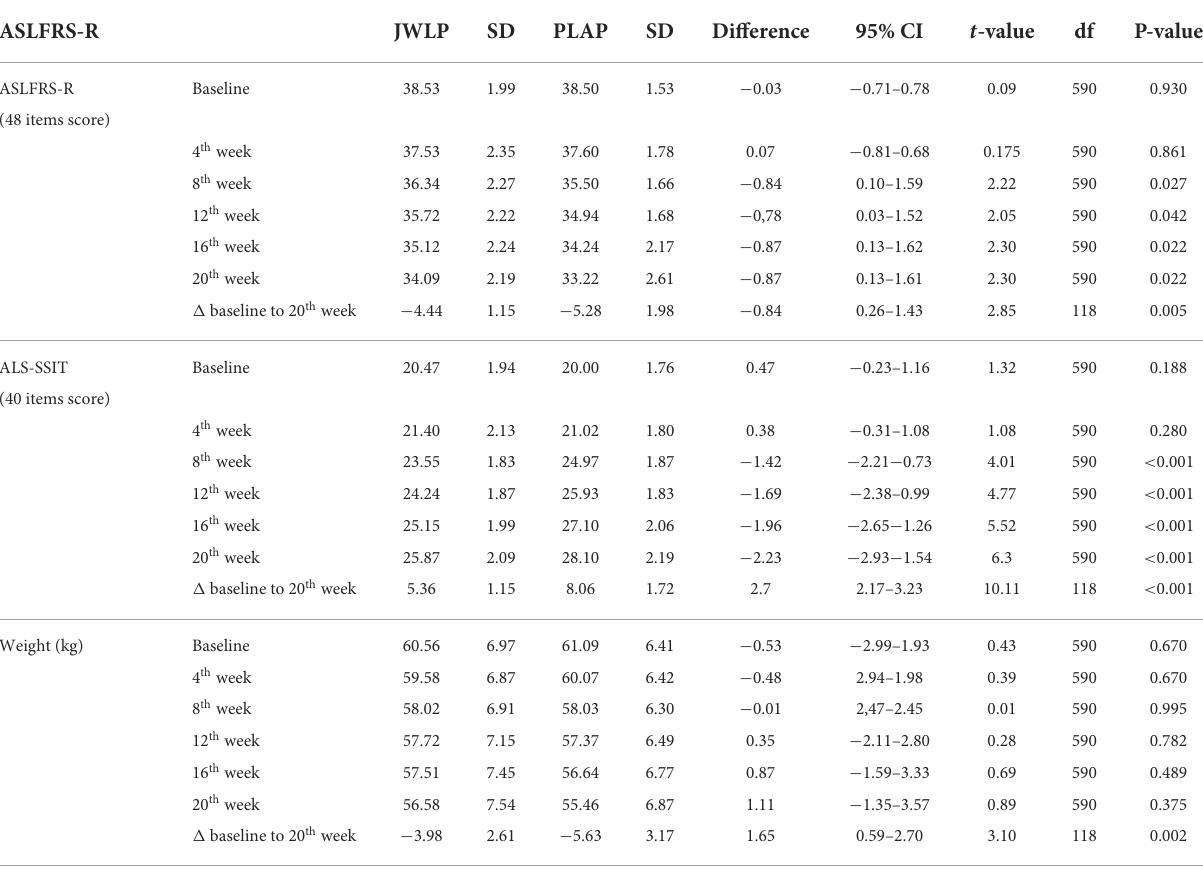
TABLE 3 ALSFRS-R, ASL-SSIT, and weight over 20 weeks.